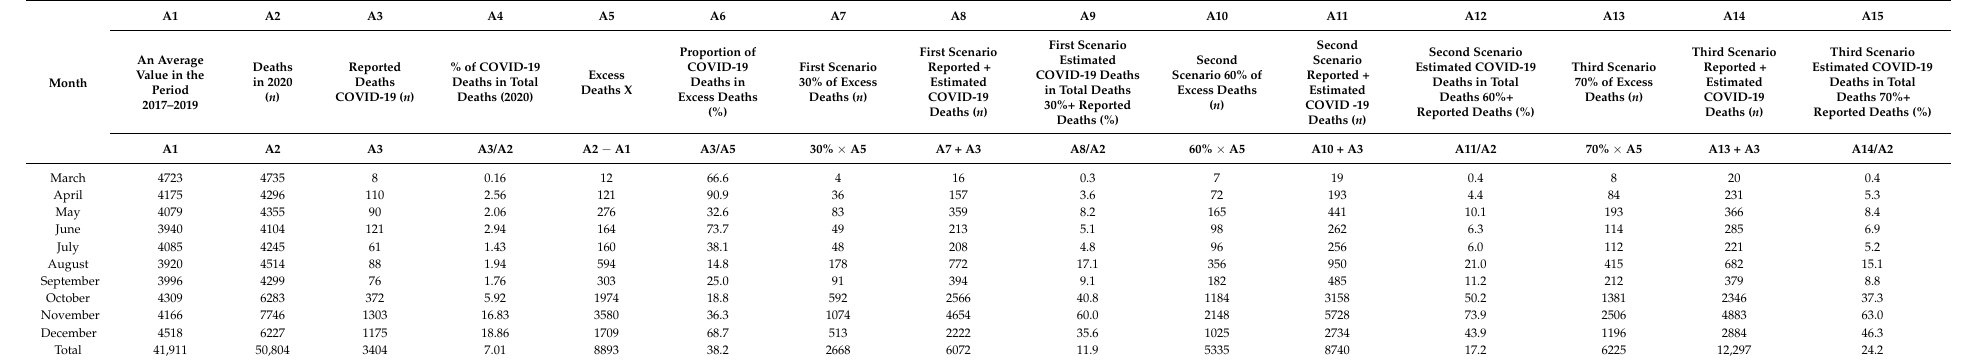
Table 5. Total and COVID-19 deaths in the Silesian voivodship in